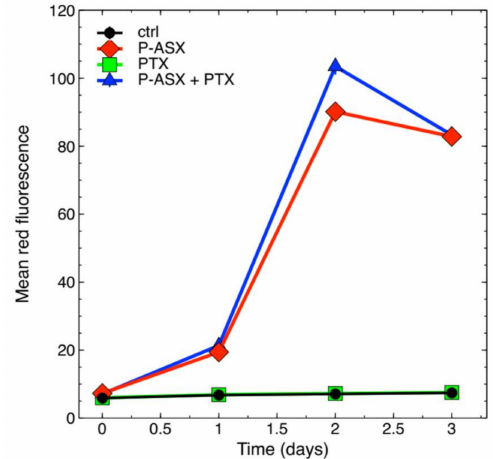
Figure 2. Phagocytosis kinetics of ASX microparticles. The cells were exposed to ASX microparticles (P-ASX) and were either treated or left untreated with PTX at a final concentration of 8 µ g/mL. Phagocytosis was measured by flow cytometry thanks to the fluorescence emission of the ASX- containing oleoresin encapsulated into the protein particles. In this figure cell autofluorescence of control untreated cells (ctrl) or of cells treated with PTX only is also shown. Values are given as mean ± SE. The error bars correspond to calculated standard errors and are not clearly visible in this figure because they are masked by the symbols (min. and max. coefficient of variation, CV=100 ∗ SE/mean, 0.45% and 5.1%,